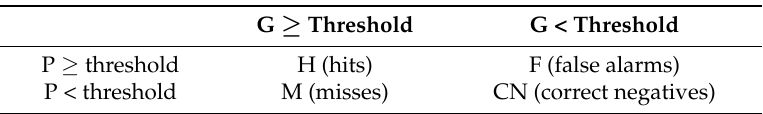
Table 1. The 2 × 2 contingency table summarizing the agreement between rain gauges (G) and satellite precipitation products (P) for each precipitation threshold.